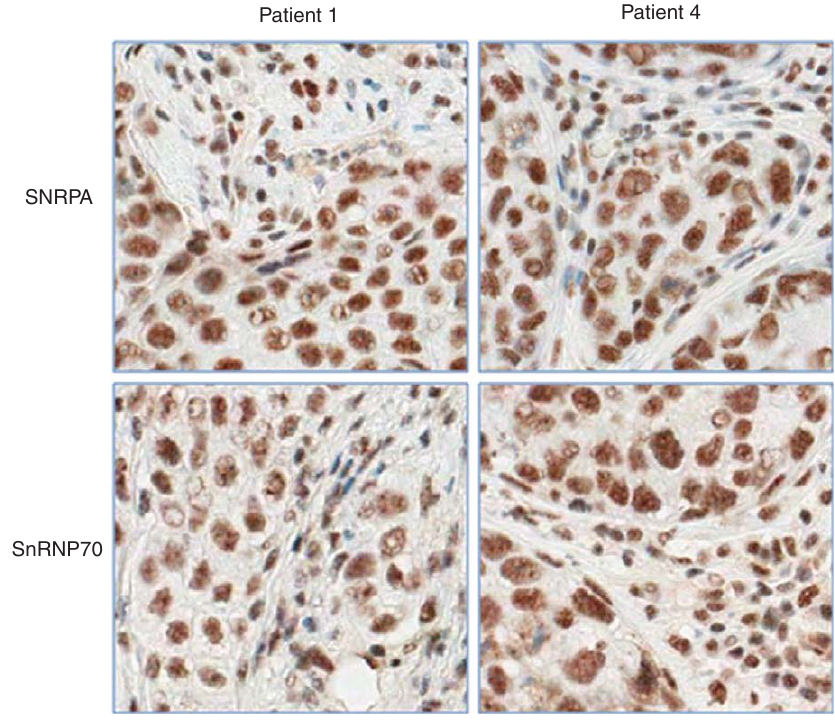
Fig. 3. Representative IHC staining for candidate calibrators in FFPE-derived human breast cancer tissue. SNRPA and SnRNP70 IHC staining is shown for breast cancer –derived sections for patients 1 and 4 from this study (fixed for 48 hours without delay following surgical resection). Note that the nuclear-specific staining (devoid of cytoplasmic background stain) is consistent for each candidate calibrator across patients tested for any given set of fixation